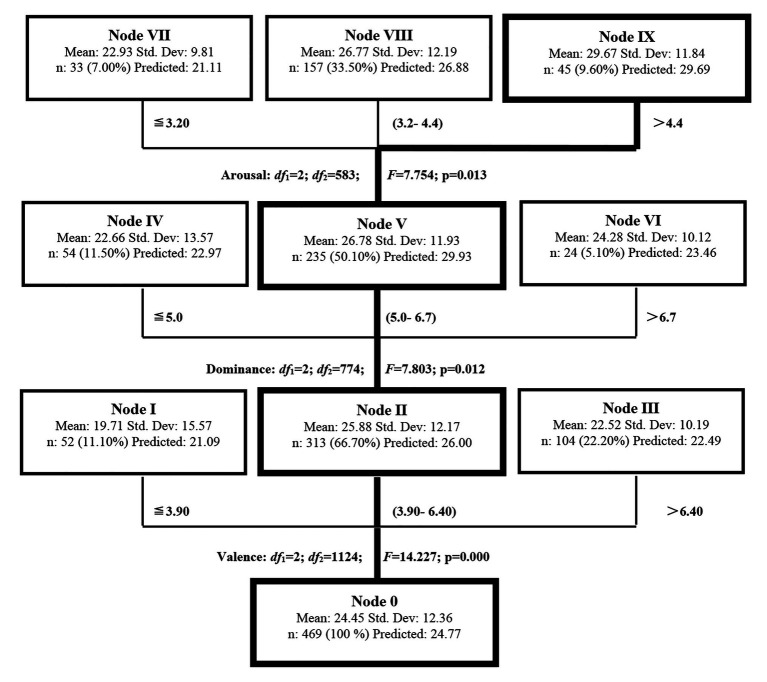
The DT model for L2 lexical attrition.